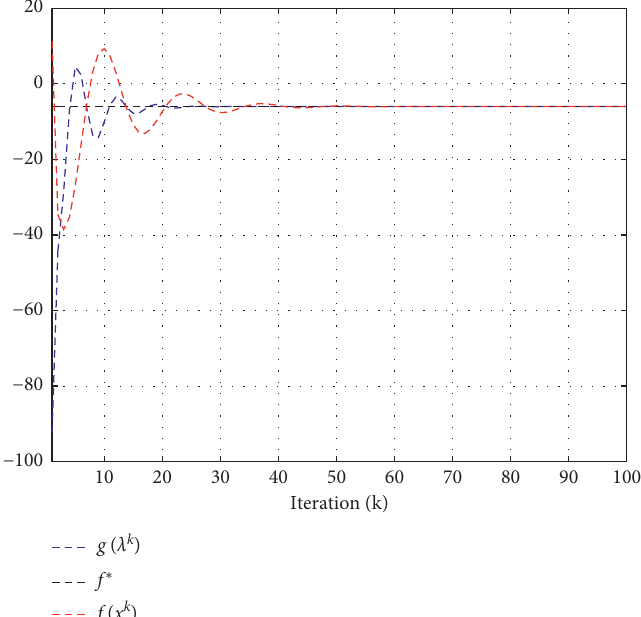
Figure 12: Convergence of the dual function and objective function iterates in ADMM. Horizontal line represents the optimal value f ∗ � − 6 of the primal problem (45). The figure shows the iterates almost converge to f ∗ within 100